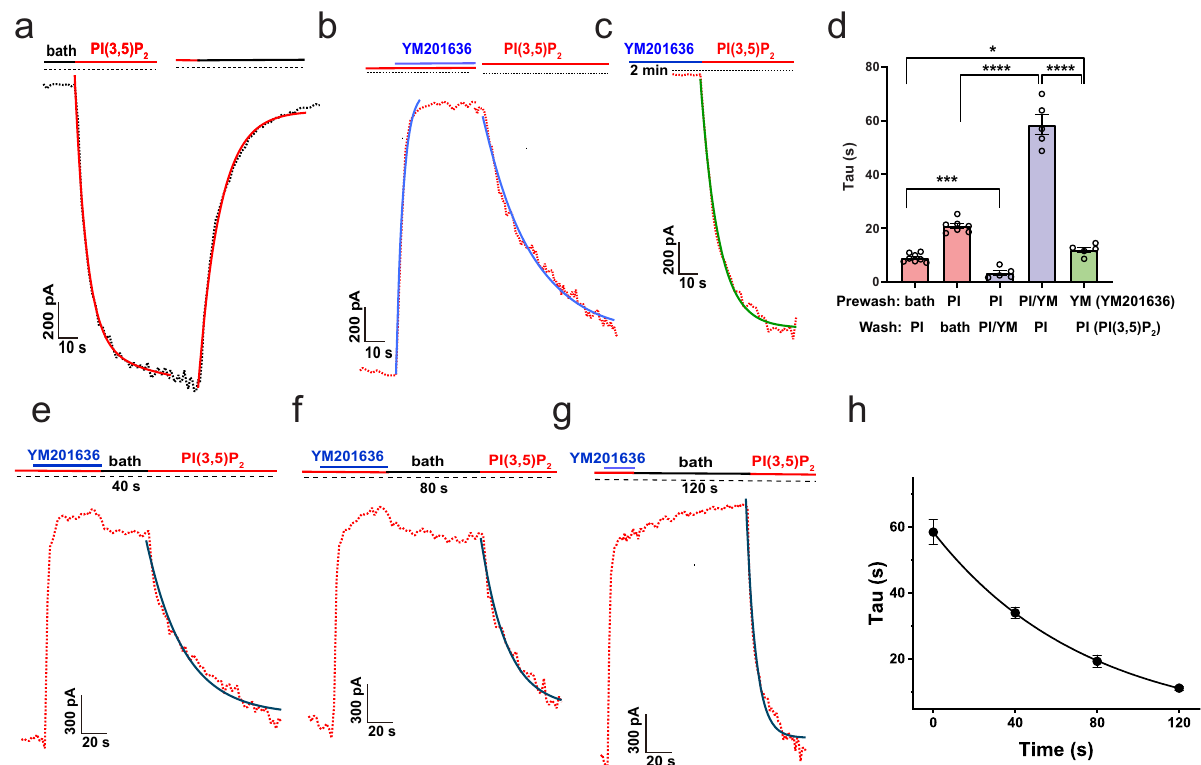
Fig. 3 The state dependence of human TPC2 inhibition by YM201636. a Representative TPC2 PM currents upon activation by 1.0 μ M PI(3,5)P 2 and deactivation by wash-off of the ligand. b The inhibition and restoration of TPC2 PM currents (pre-activated by PI(3,5)P 2 ) upon wash-on and wash-off of 1.0 μ M YM201636. c The PI(3,5)P 2 (1.0 μ M)-induced TPC2 PM currents after 2-min treatment of the closed channels (in the absence of an activator)